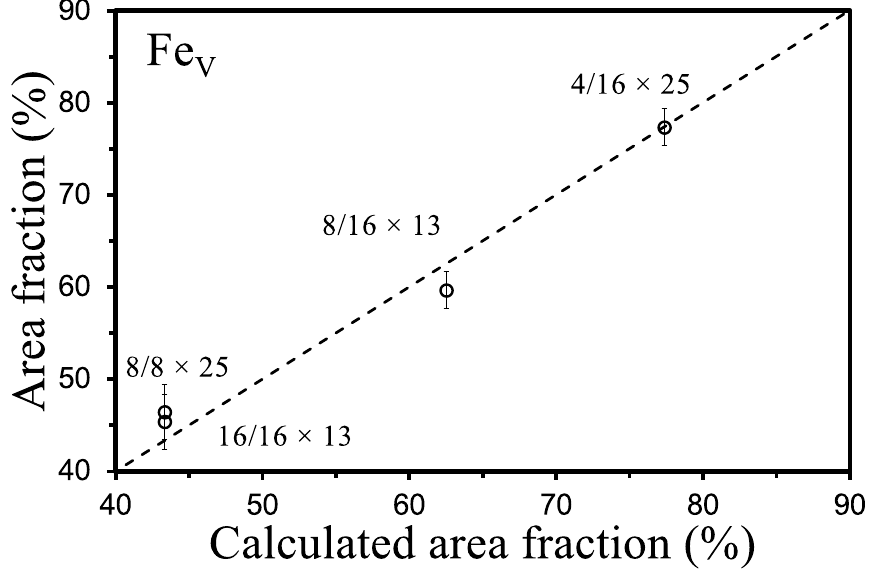
Figure 6. Plot of the calculated (horizontal) versus the measured (by eMS, vertical) area fraction of the Fe V component in different superlattice structures (the dotted line represents the calculated, the unfitted circles represent the measured area fraction of the superlattice as indicated).